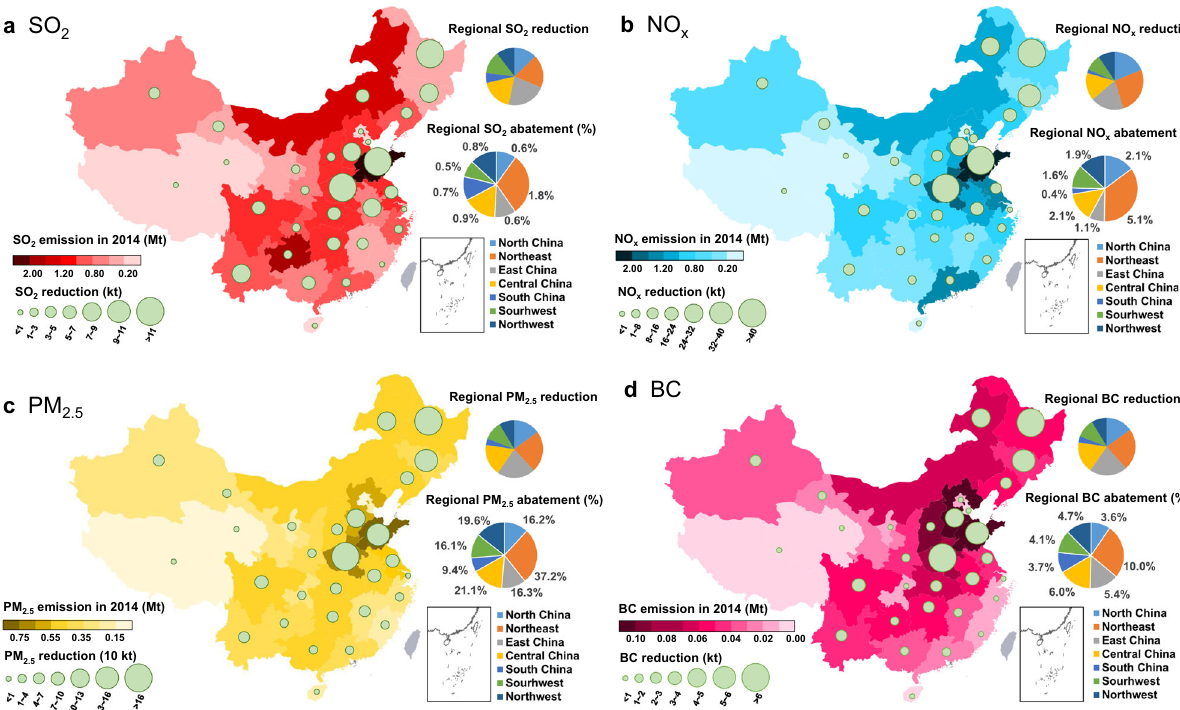
Fig. 5 Reductions in annual air pollutant emissions (SO 2 , NO x , PM 2.5 , and BC) achieved by nationwide deployment of BIPP systems with biochar sequestration. a The annual SO 2 emissions reduction, the red color shading represents the levels of SO 2 emissions in 2014; b the annual NO x emissions reduction, the blue color shading indicates the levels of NO x emissions in 2014; c the annual PM 2.5 emissions reduction, the yellow color shading shows the levels of PM 2.5 emissions in 2014; d the annual BC emissions reduction, the pink color shading represents the levels of BC emissions in 2014. The green round labels in a – d indicate total emissions reductions by province resulting from three sources: BIPP substitution for other energy uses, avoided domestic biomass burning (DBB), and avoided open biomass burning (OBB). The regional divisions in a – d are shown in Supplementary Fig. 9, and the regional pollutant emissions abatement (%) is de fi ned as the regional emissions reduction divided by the regional emissions in